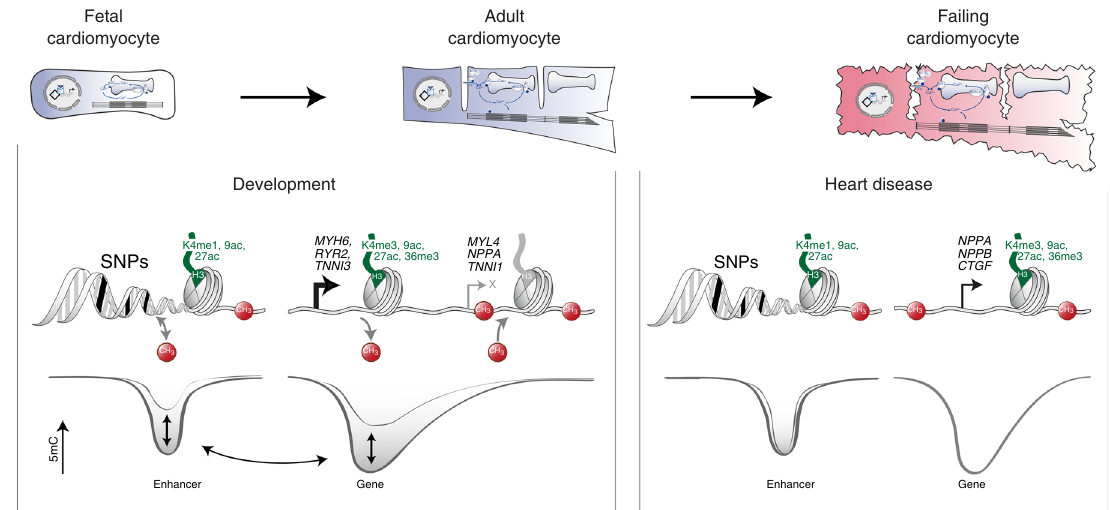
Fig. 7 Dynamics of mCpG and histone modi fi cations in gene bodies and enhancer regions of cardiac myocyte genes during heart development and in chronic heart failure. During cardiac myocyte development, mCpG of enhancers (LMR low methylated region, Fig. 4) and genic regions (gUMR genic unmethylated region, Fig. 2) and canonical histone marks cooperate to induce ( MYH6 , RYR2 , TNNI3 ) or repress ( MYL4 , NPPA , TNNI1 ) cardiac myocyte genes (left panel, Fig. 1f). In failing cardiac myocytes (right panel), induction of disease-associated genes is accompanied by active histone marks without changes in gene body mCpG (Fig. 3b). Some LMRs showed small changes in mCpG in heart failure (Fig. 5a). Low methylated regions with enhancer signature were signi fi cantly enriched for single-nucleotide polymorphisms (SNP), which have been linked with cardiac disease (Fig. histone marks (Fig. 5c, group II), gUMR mCpG, or gene expression of adjacent genes (Fig. 5e, f). This indicates that disease-associated alterations of mCpG are rare and not directly linked to alterations of other inheritable marks or gene expression.